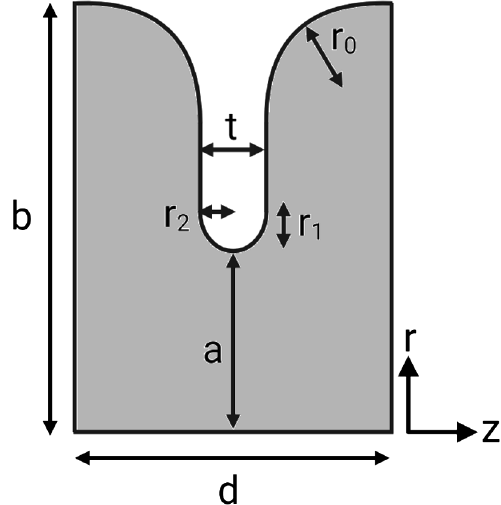
=E 2 as a function of acc c